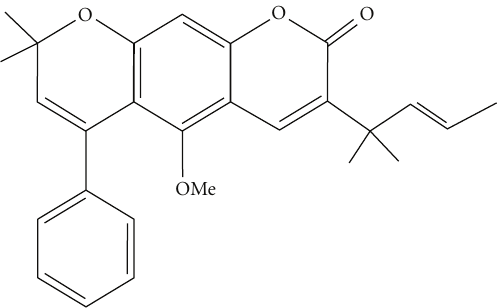
Figure 2: Phenyl derivative of pyranocoumarin